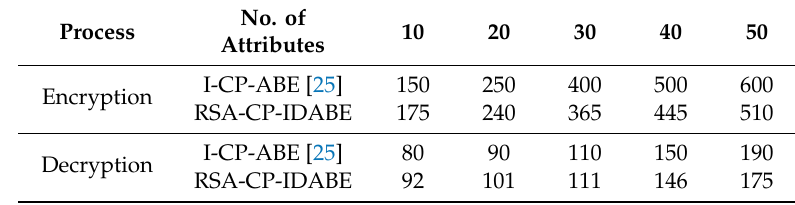
Table 5. Encryption, decryption time vs. the number of attributes.